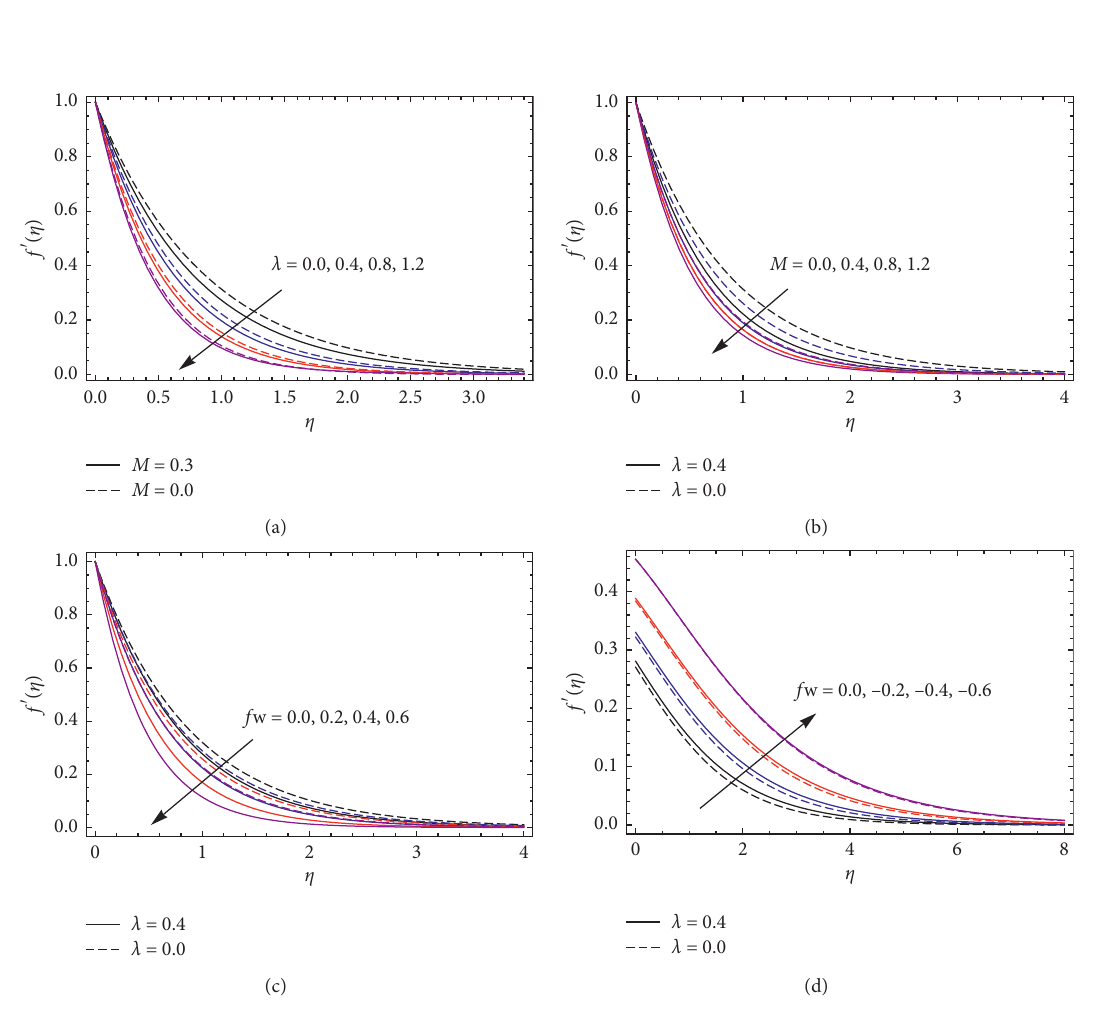
Figure 3: Impact of velocity on the different values of parameters. (a) λ � 0 . 0 , 0 . 4 , 0 . 8 , 1 . 2, (b) M � 0 . 0 , 0 . 4 , 0 . 8 , 1 . 2 , (c) fw � 0 . 0 , 0 . 2 , 0 . 4 , 0 . 6, and (d) fw � − 0 . 0 , − 0 . 2 , − 0 . 4 , − 0 . 6.